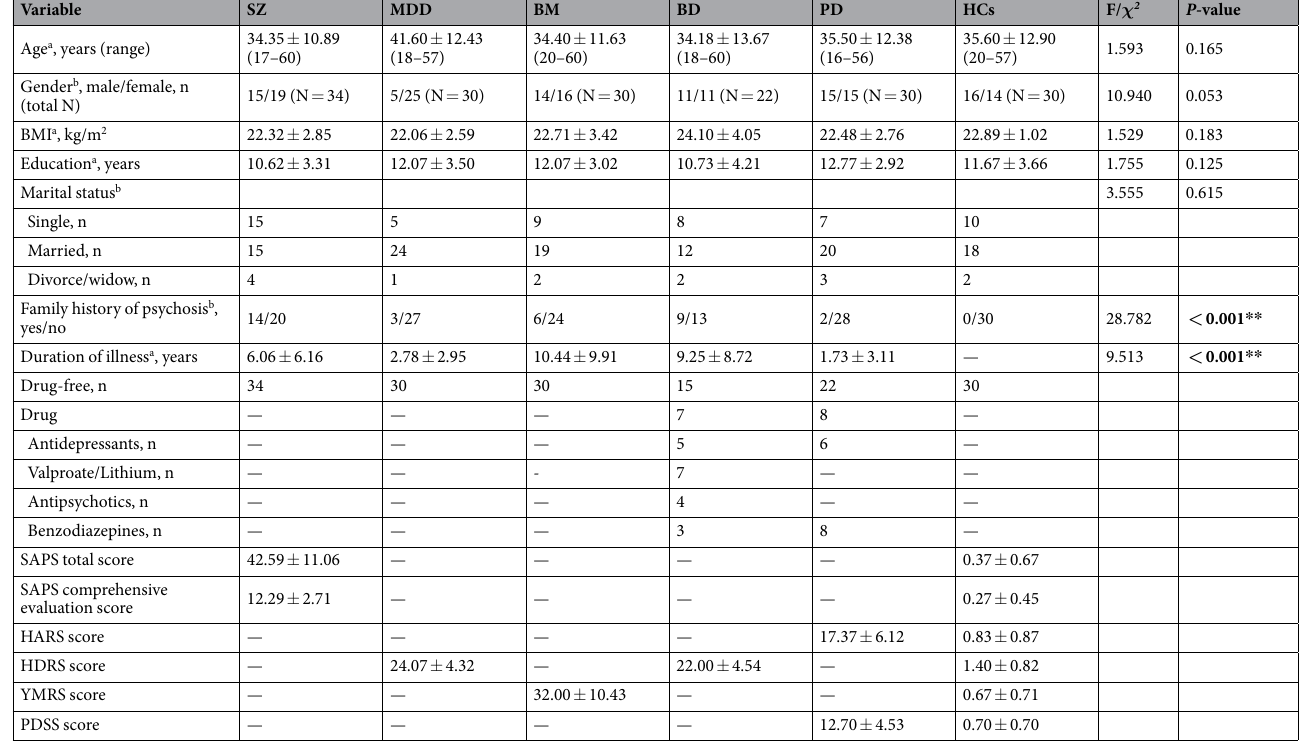
Table 1. Demographic and clinical characteristics of participants. Note: Abbreviations: SZ, schizophrenia; MDD, major depressive disorder; BM, bipolar mania; BD, bipolar depression; PD, panic disorder; HCs, healthy controls; BMI, body mass index; SAPS, Scale for Assessment Positive Symptom; HARS, Hamilton Anxiety Rating Scale; HDRS, 17-item Hamilton Depression Rating Scale; YMRS, Young Mania Rating Scale; PDSS, Panic Disorder Severity Scale. Symbol: -, no data. Comparison among six groups: a one-way ANOVA analysis, b Chi-square test.